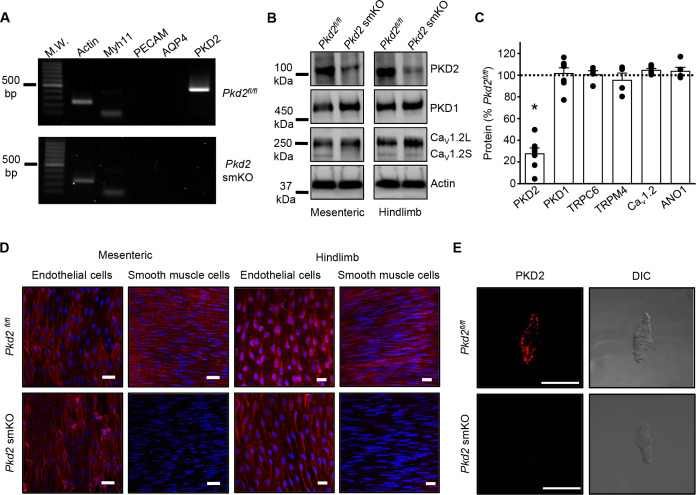
Activation of Cre recombinase abolishes PKD2 in arterial myocytes of Pkd2fl/fl:myh11cre/ERT2 mice.(A) RT-PCR showing the absence of PKD2 transcript in isolated myocytes from tamoxifen-treated Pkd2fl/fl:myh11-cre/ERT2 mice. (B) Western blots illustrating the effect of tamoxifen-treatment in Pkd2fl/fl and Pkd2fl/fl:myh11-cre/ERT2 mice on PKD2, CaV1.2L (full-length CaV1.2) and CaV1.2S (short CaV1.2) proteins in mesenteric and hindlimb arteries. (C) Mean data for proteins in mesenteric arteries of tamoxifen-treated Pkd2fl/fl:myh11-cre/ERT2 mice when compared to those in tamoxifen-treated Pkd2fl/fl mice. n = 4–7. * indicates p<0.05 versus Pkd2fl/fl. (D) En-face immunofluorescence imaging illustrating that PKD2 protein (red, Alexa Fluor 555) is abolished in myocytes of mesenteric and hindlimb arteries in tamoxifen-treated Pkd2fl/fl:myh11-cre/ERT2 mice (representative of 6 mesenteric and six hindlimb arteries). In contrast, PKD2 protein in endothelial cells is unaltered. Nuclear staining (DAPI) is also shown. Scale bars = 20 µm. (E) Confocal and DIC images illustrating that PKD2 protein (Alexa Fluor 555) is abolished in isolated mesenteric artery myocytes of tamoxifen-treated Pkd2fl/fl:myh11-cre/ERT2 mice (representative data from 5 Pkd2fl/fl and 5 Pkd2fl/fl:myh11-cre/ERT2 mice). Scale bars = 10 µm.